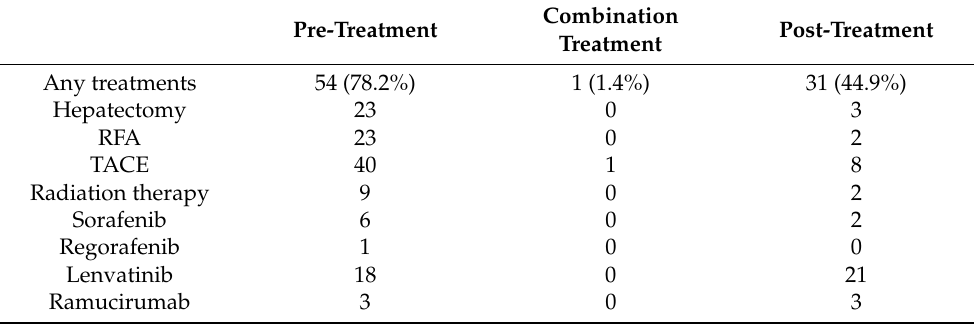
Table 2. The pre-, combination, and post-treatment of the patients receiving atezolizumab plus bevacizumab treatment.